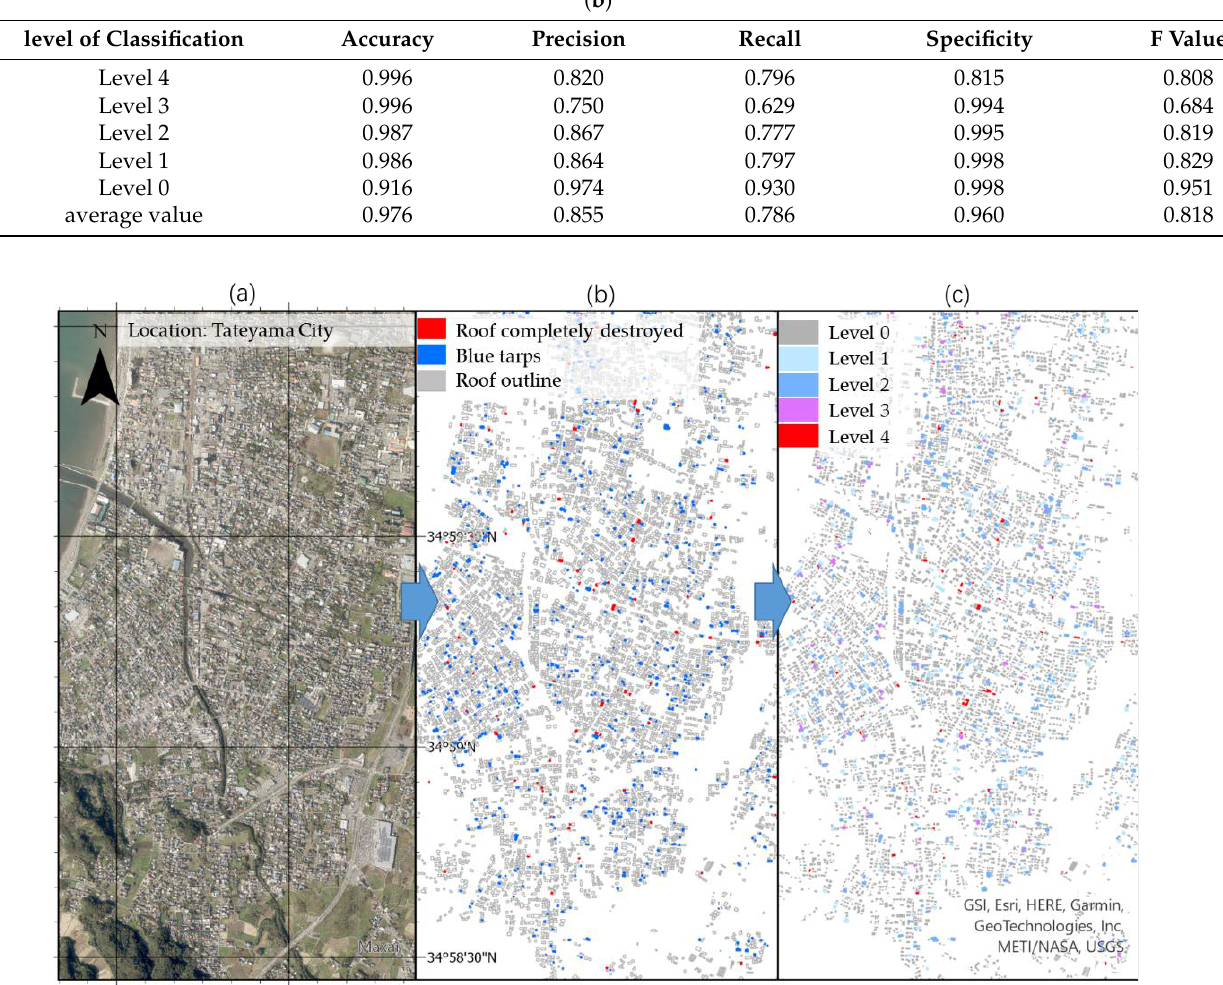
Figure 16. Results of the detection and classification for the green areas in Figure 3. ( a ) Aerial photo in Tateyama city. ( b ) Each detected object using deep learning. ( c ) the level of roof damage using automatically classification.